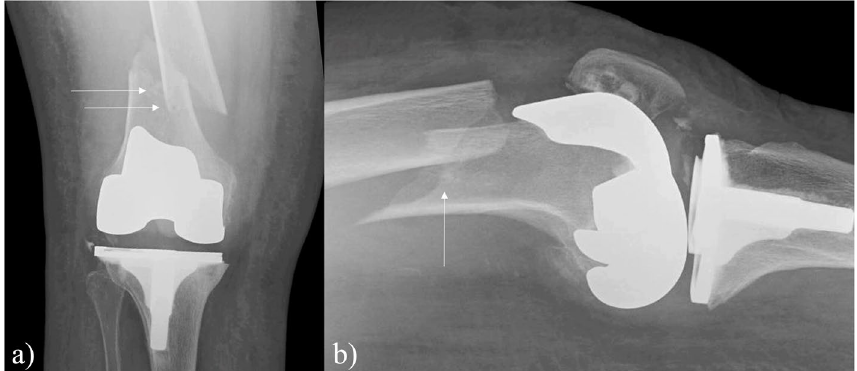
Fig. 4 a AP and b lateral radiographs of a right distal femur postoperative pin-site periprosthetic fracture in a 75-year-old female following robotic-assisted total knee arthroplasty with the large pin diameter system. Arrows demarcate pin tracts, with the fracture line seen passing through the proximal pin tract